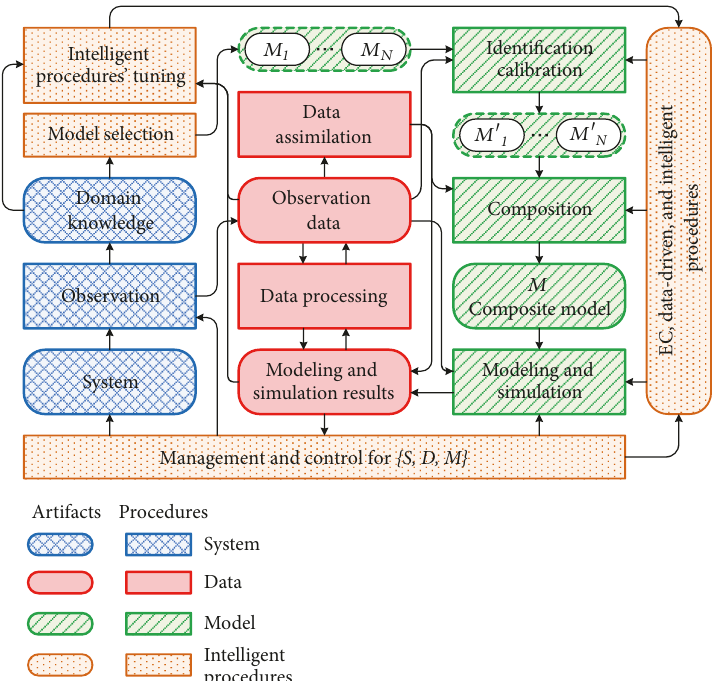
Figure 3: Artifacts and procedures within a typical composite